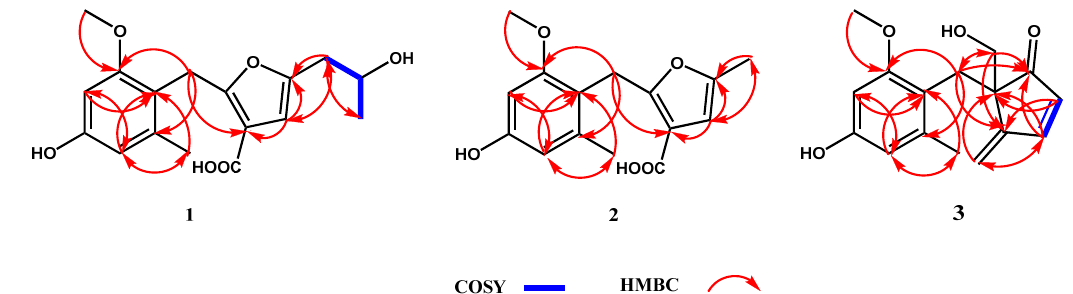
Figure 2. Key 1 H- 1 H COSY and HMBC correlations of compounds 1 – 3.